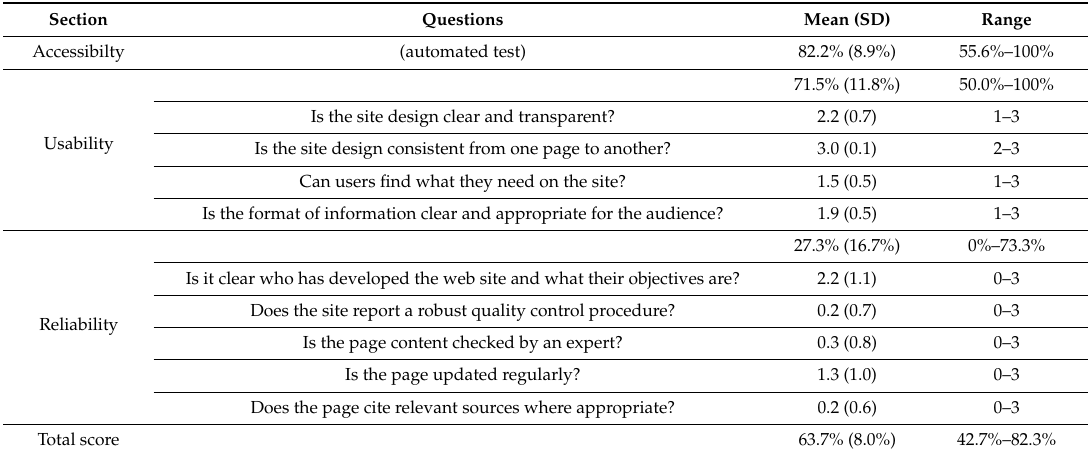
Table 1. Scores of the included websites ( N = 85) measured by the LIDA